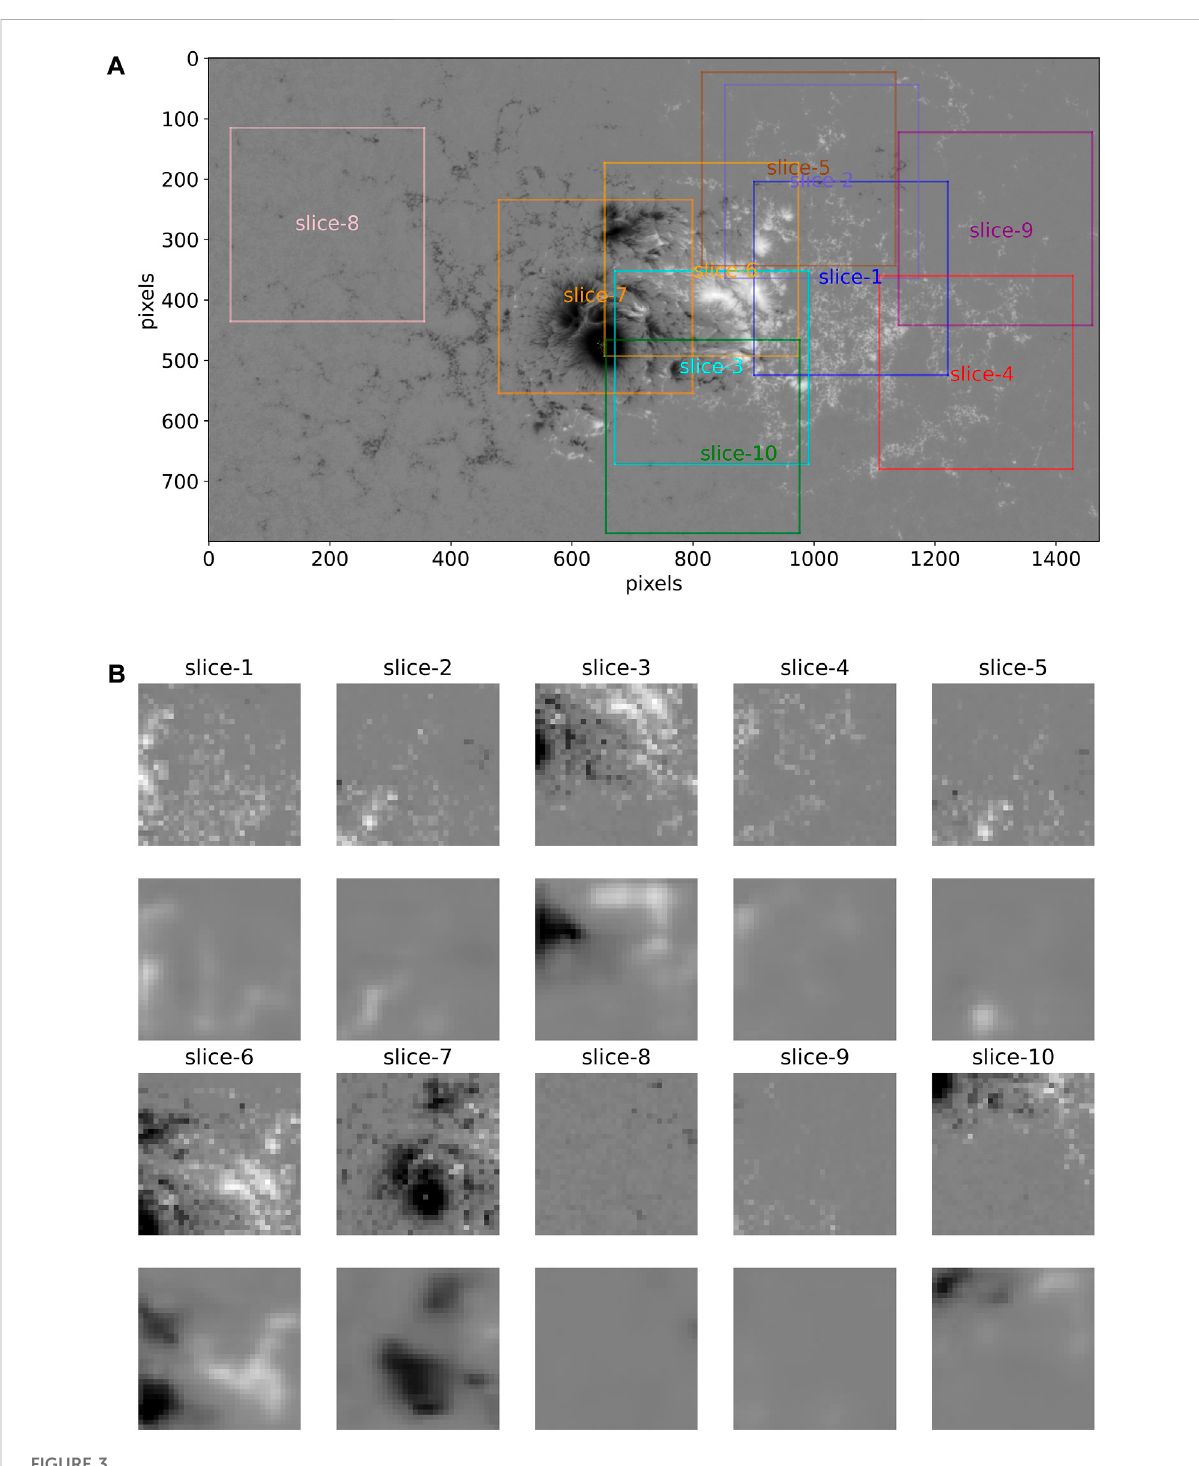
FIGURE 3 Illustration of the data preparation and the results by the auto-encoder network, similar to Figure 2. (A) is the radial magnetic fi eld of AR12192 (corresponding to SHARP patch number 4698) before the X1.6 fl are erupted at 14:28 UTC, on 22 Oct 2014. There are ten slices (with a size of 320 × 320 pixels) cut randomly from the original observations. (B) is similar to Figure